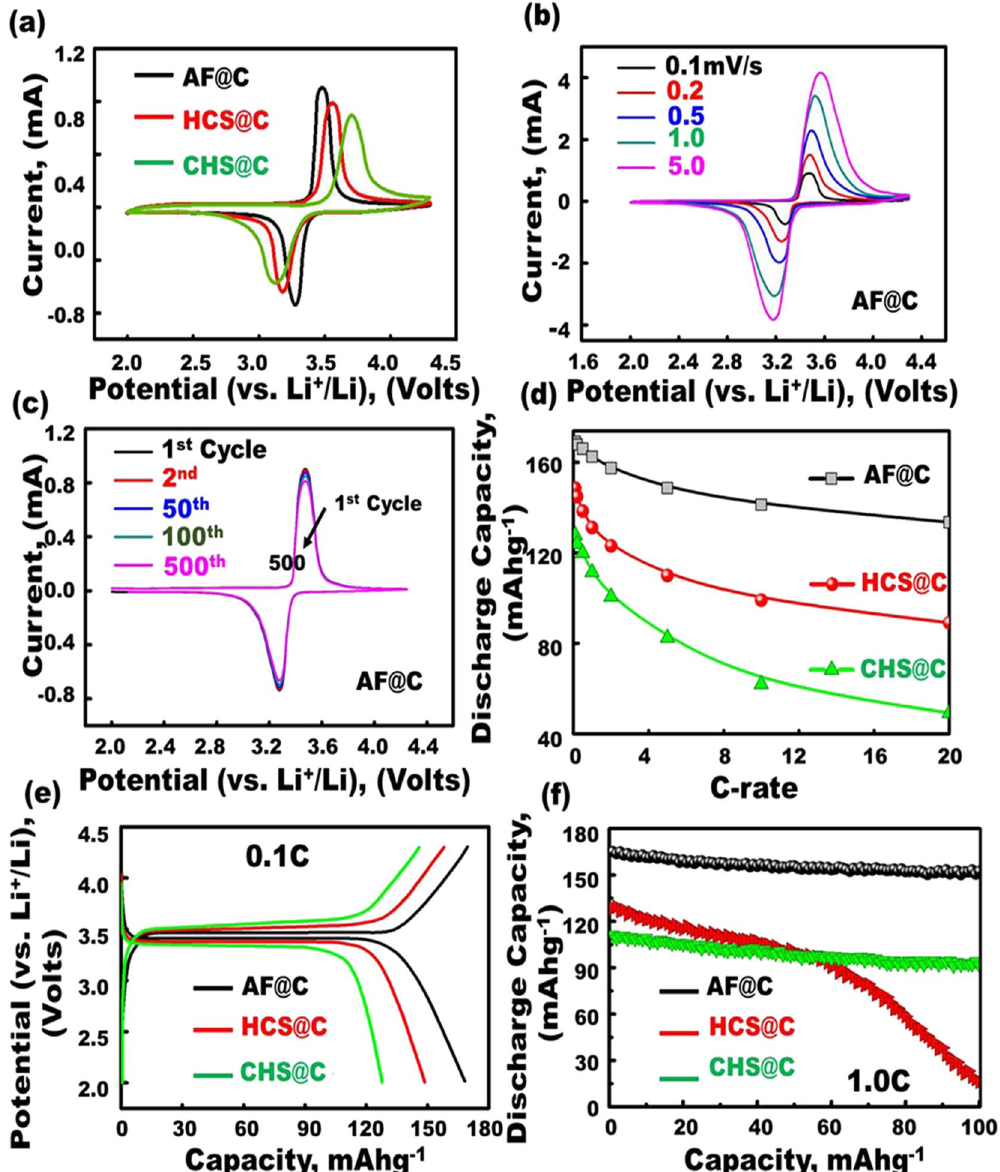
Figure 4. ( a , b , c ) Cyclic voltammograms obtained from the comprehensive analysis of the electrochemical performance of the anode composites (2032 coin-type half-cell tests with a Li counter electrode). ( a ) CV curves of different structures of geodesic LFPO AF@C with convex spheres and serrated cuticles, HCS@C, and CHS@C as cathode. ( b ) CV curves of AF@C half-cell cathode at different sweep rates (0.1, 0.2, 0.5, 1, and 5 mVs − 1 and ( c ) CV curves of AF@C half-cell cathode at different cycle numbers 1–500 cycles at 0.1 mVs − 1 . ( d ) First discharge capacity of all LFPO@C of different morphologies (AF@C, HCS@C, and HCS@C) at current rates of 0.1–20 C in half-cell LIBs. ( e ) Charge–discharge voltage profiles of first-cycle AF@C, HCS@C, and HCS@C cathode of different morphologies in half-cell LIBs by using 2032 coin cell with Li foil as the counter electrode at a current rate 0.1 C. ( f ) Cycling performance stability used for AF@C, HCS@C, and HCS@C cathodes at a rate of 1 C for 100 cycles. All electrochemical measurements for half-cell cathodes were operated within a voltage range of 2.0–4.3 V at room